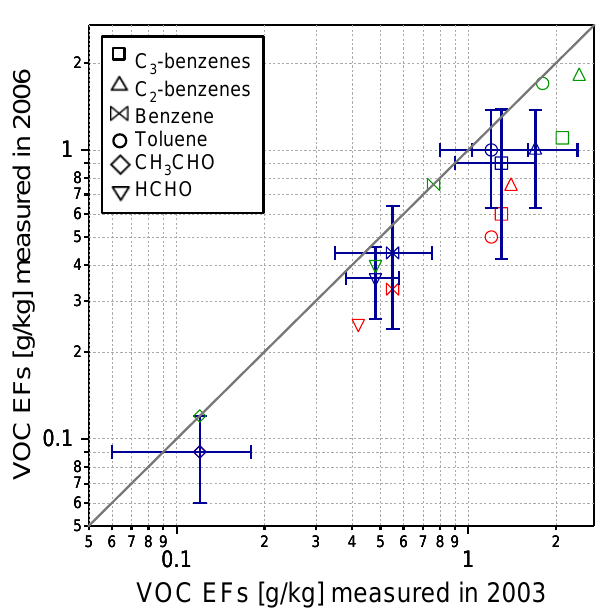
Fig. 1. Comparison of on-road fuel based emission factors (EFs, g/kg) of various VOC pollutants measured in 2003 and 2006 with the ARI mobile laboratory in Mexico City for SAG (green), TRA (blue) and CRU (red) driving conditions. Error bars are shown for TRA driving conditions and represent one standard deviation of the measured